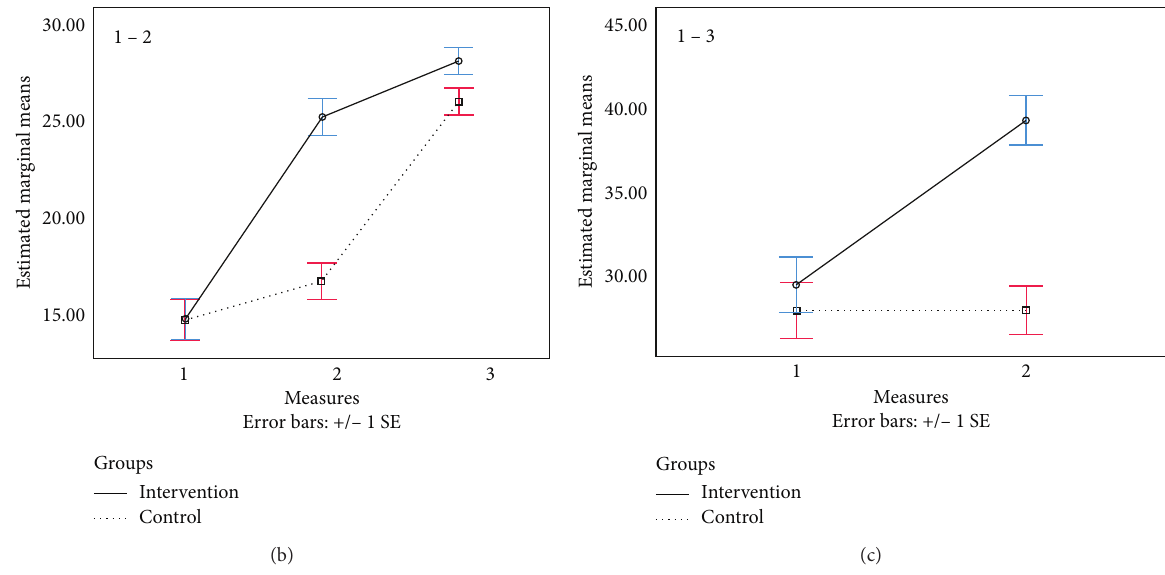
Figure 1: Interaction of time–group for measurements: (a) 1-1, knowledge, (b) 1-2, performance, and (c) 1–3, total